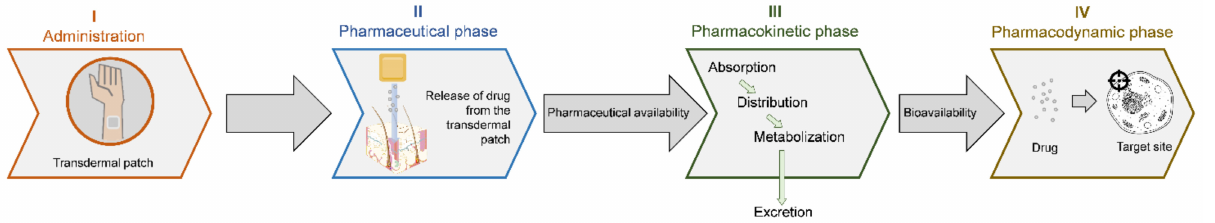
Figure 1. From drug administration to its pharmacological effect. Upon administration (phase I), the drug is released from the pharmaceutical patch through the skin (phase II), after which the compo- nents are pharmaceutically available to be processed by the phase III-ADME system (absorption, distribution, metabolism and excretion). Once the drug reaches the systemic circulation, it becomes bioavailable to proceed to the target site and perform the pharmaceutical action (phase